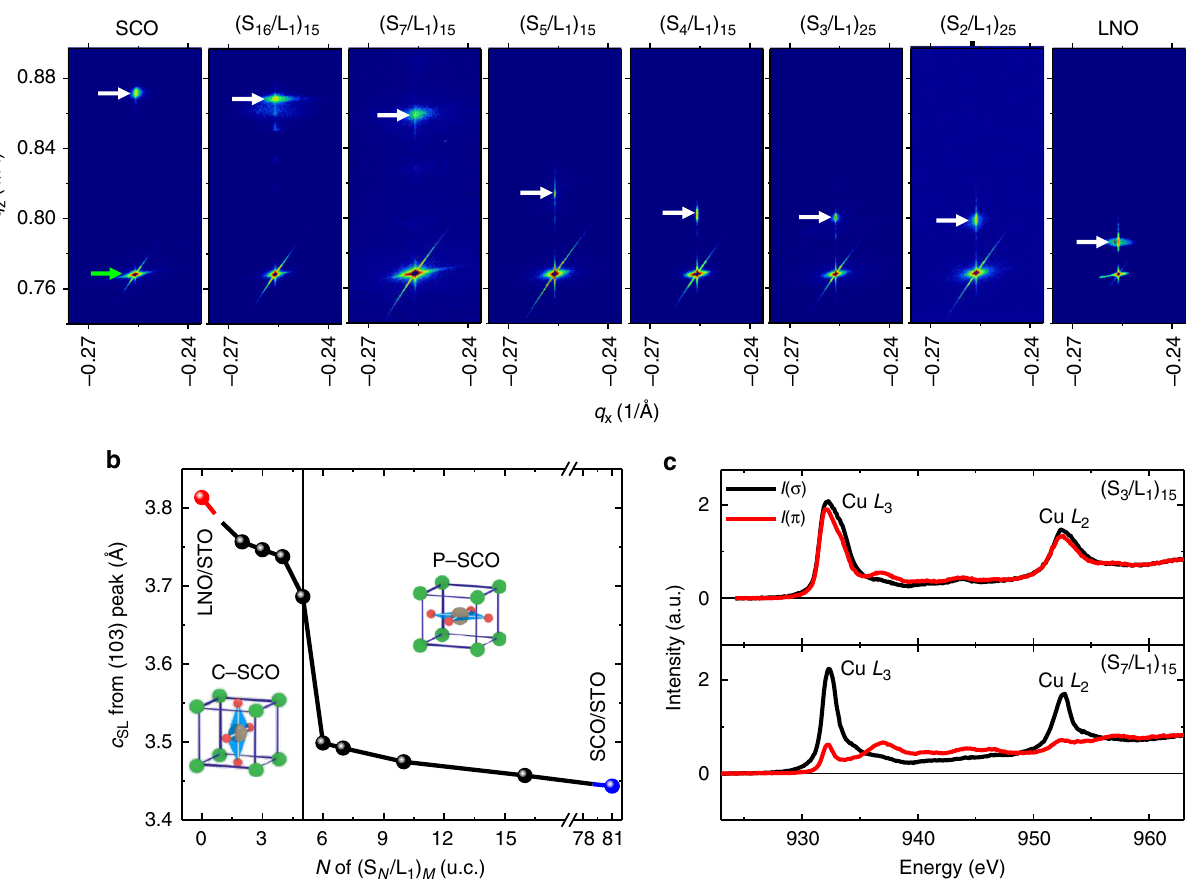
Fig. 2 Dimensional control of the sub-lattice structure of SrCuO 2 . a Reciprocal space mapping of the 103 peak of a LaNiO 3 (LNO) fi lm, ((SrCuO 2 ) N /LNO 1 ) M superlattices and a SrCuO 2 (SCO) fi lm. The green and white arrows indicate SrTiO 3 (STO) substrate and fi lm/superlattice peaks, respectively. b Out-of- plane lattice constant ( c ) as a function SCO sublayer thickness ( N ). The sudden change of c across N = 5 u.c. indicates a structural transition from a planar type to a chain type. c Polarization dependent XAS of Cu L 2,3 edge for S 7 /L 1 (top panel) and S 3 /L 1 (bottom panel) superlattices, demonstrating a clear contrast on the orbital